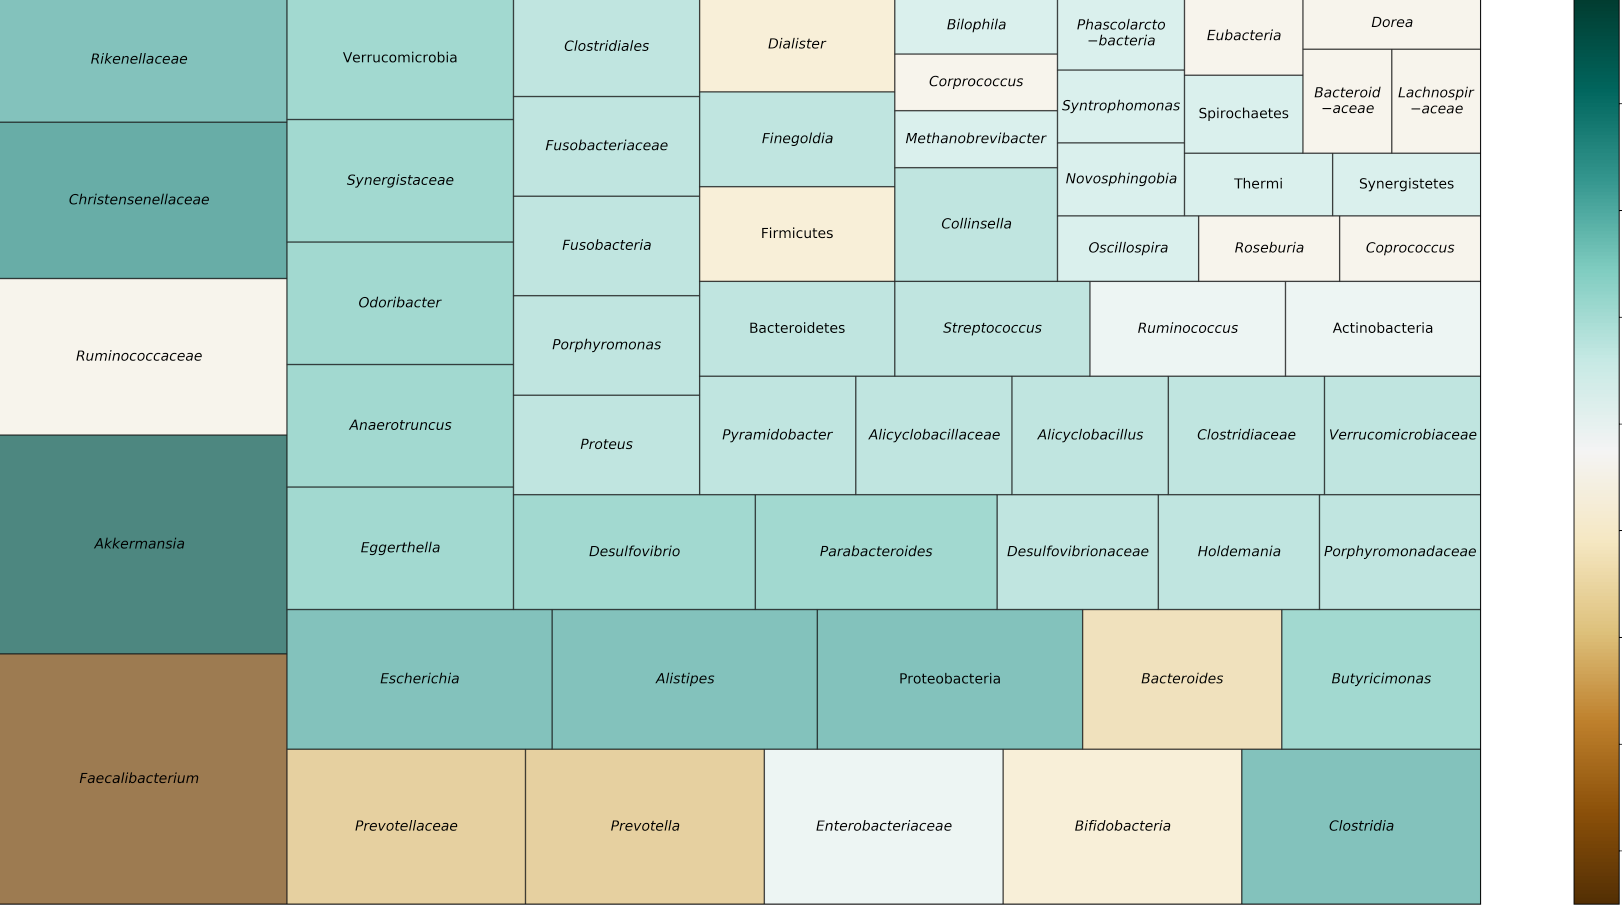
Figure 2. Microbial taxa reported to be di ff erentially abundant in long-living individuals across reviewed studies. Area represents proportion of studies reporting each taxon. Color indicates the direction and net strength of observed findings. Data in this figure are based on nine studies